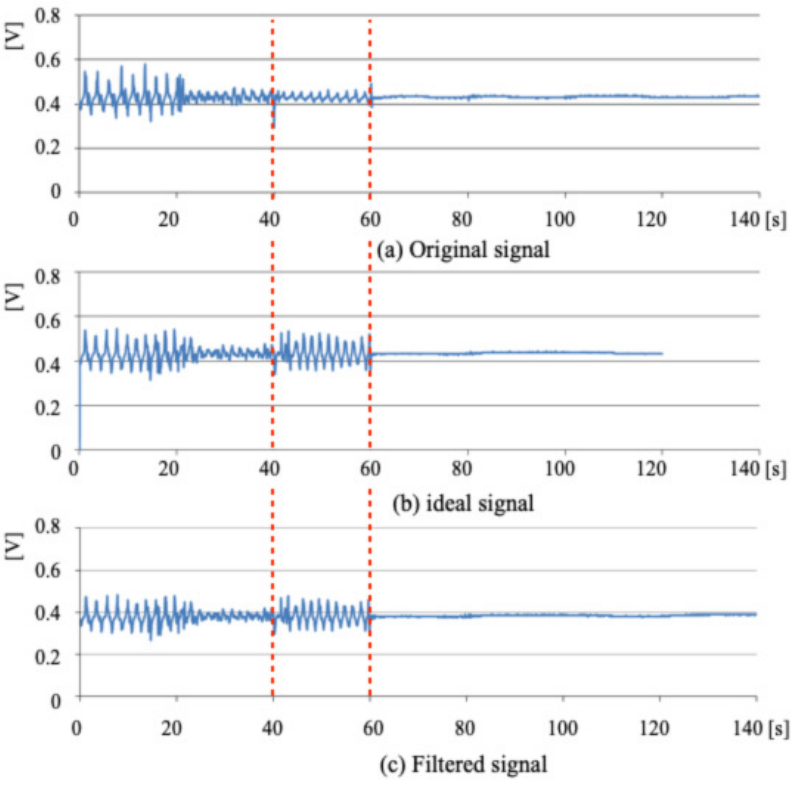
Figure 6. Original and filtered sensor